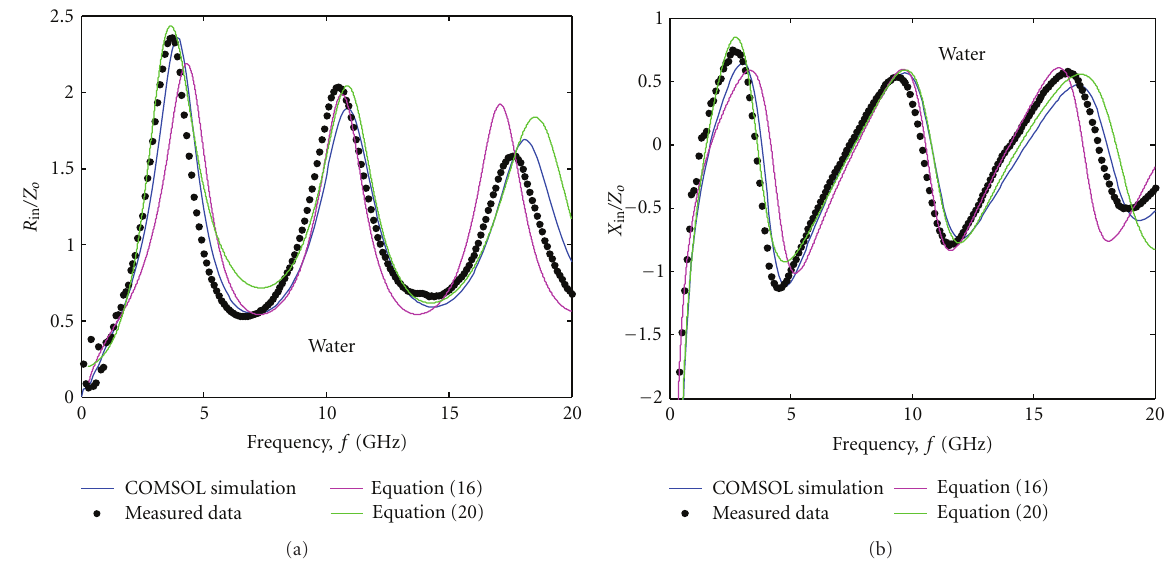
Figure 14: Comparison of (a) normalized resistance, R in /Z o , and (b) normalized reactance, X in /Z o , for water at 25 ◦ C by considering size of probe with a = 0 . 65mm, c = 2 . 05 mm, and h = 13 . 92